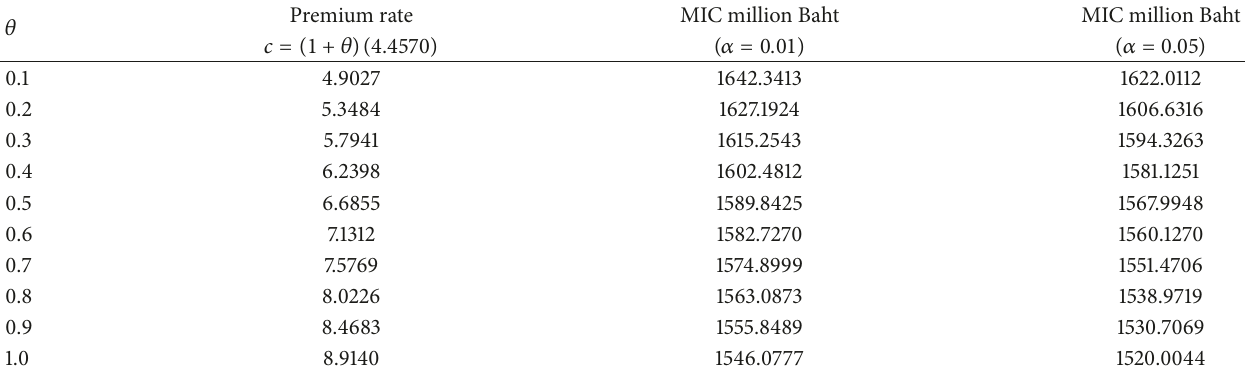
Table 6: The MIC of a reinsurance company has to hold for ensuring that the ruin probability is not greater than 𝛼 . 𝜃 Premium rate MIC million